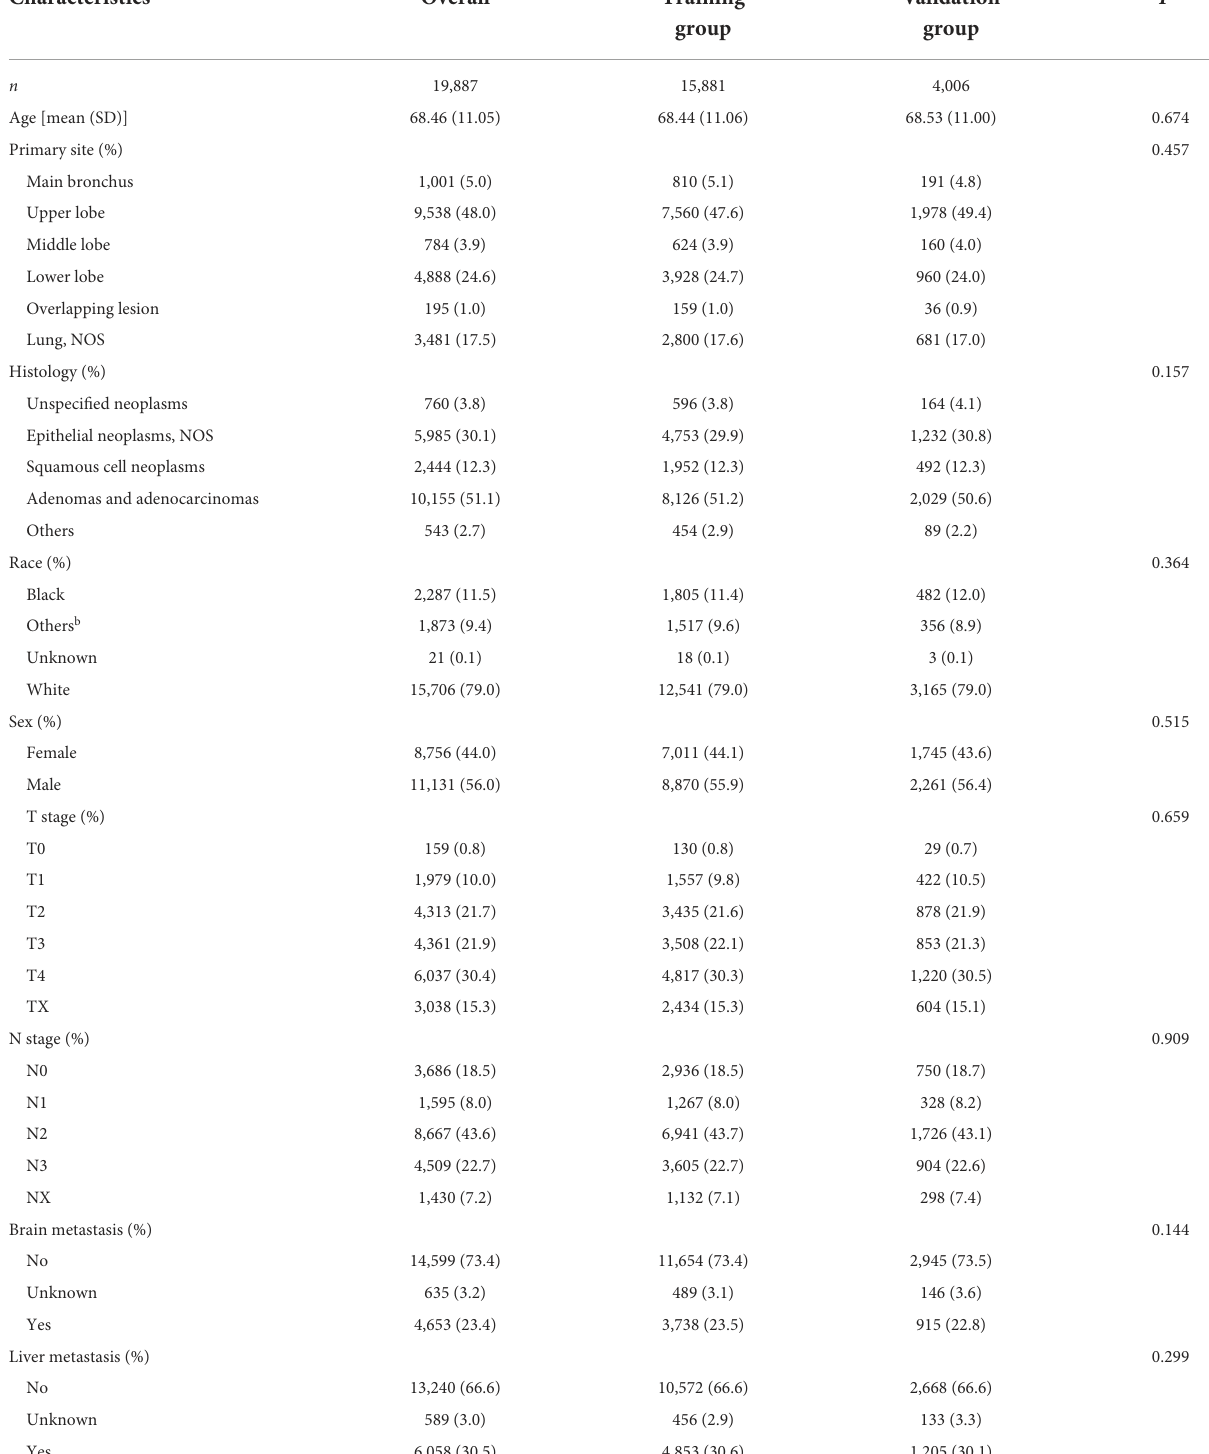
TABLE 1 Patient’s demographics, clinical characteristics, and therapeutic strategies.